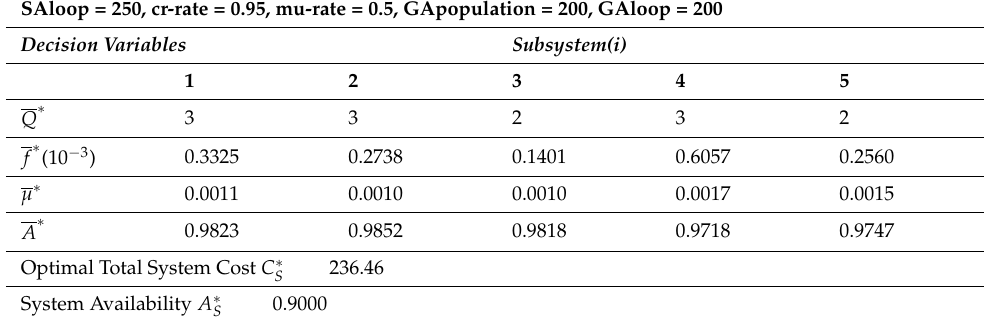
Table 10. Optimal Solutions obtained by SA–MGA for the n -stage standby system.